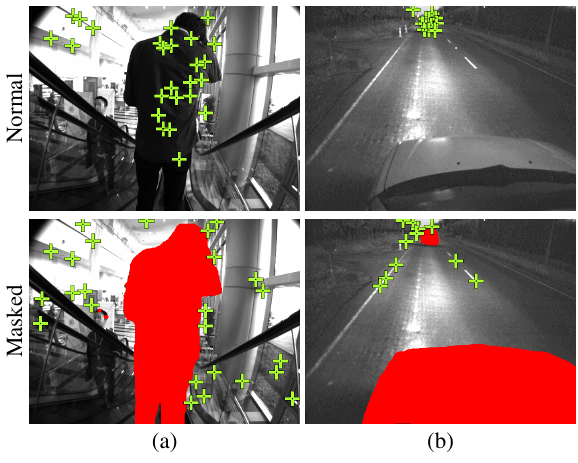
Figure 1. Illustration of selected features (green crosses) used for pose estimation in VIO without (Normal) and with (Masked) segmentation aid (red area) for a hand-held navigation on an escalator (a) and vehicle navigation at night (b, the brightness was increased for better